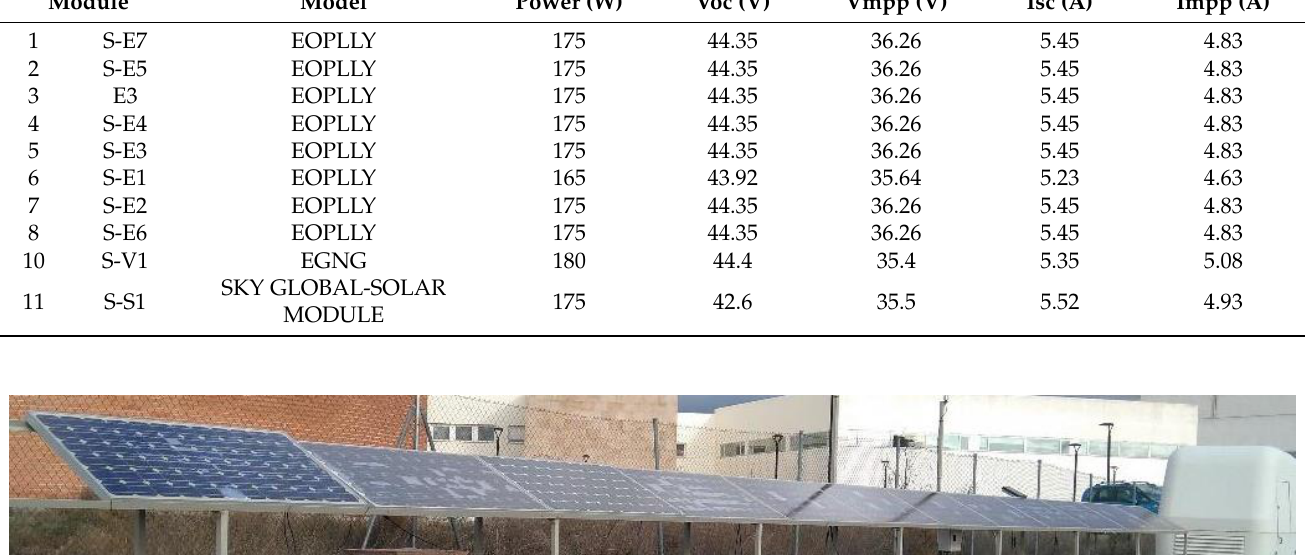
Figure 1. Experimental installation implemented in the Duques de Soria University Campus of the University of Valladolid, Soria (Spain).